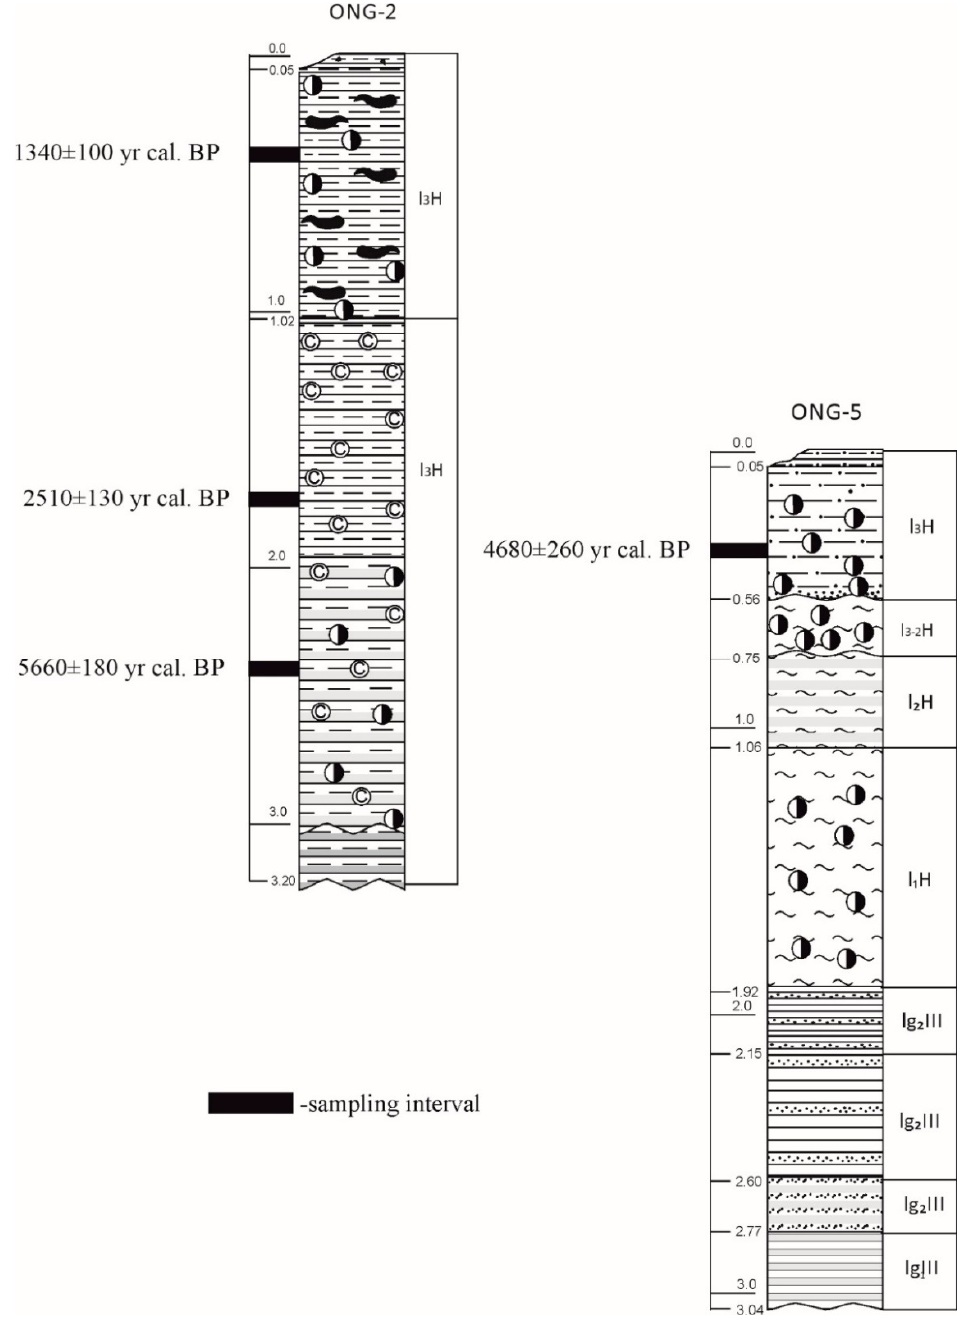
Figure 10. Results of the radiocarbon dating in cores ONG -2 and ONG- 5. Legend see Figure 8. The sedimentation rates were based on radiocarbon dating of bottom sediments from ONG-2